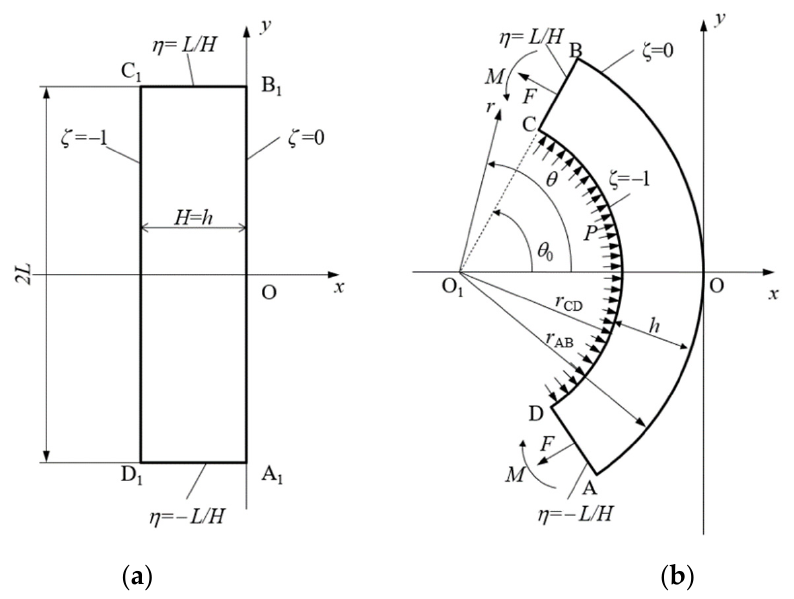
Figure 1. Schematic diagram of the process: ( a ) initial configuration, ( b ) intermediate and final configurations.